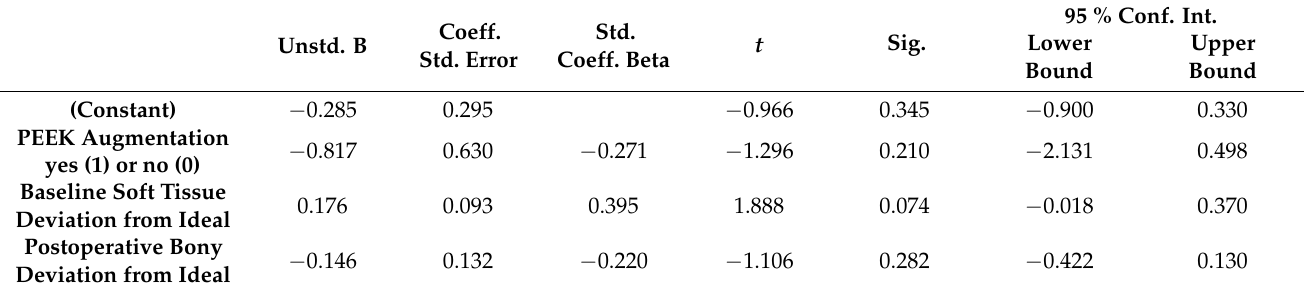
Table 5. Multivariable regression analysis of coefficients. Dependent variable: soft tissue deviation from ideal.